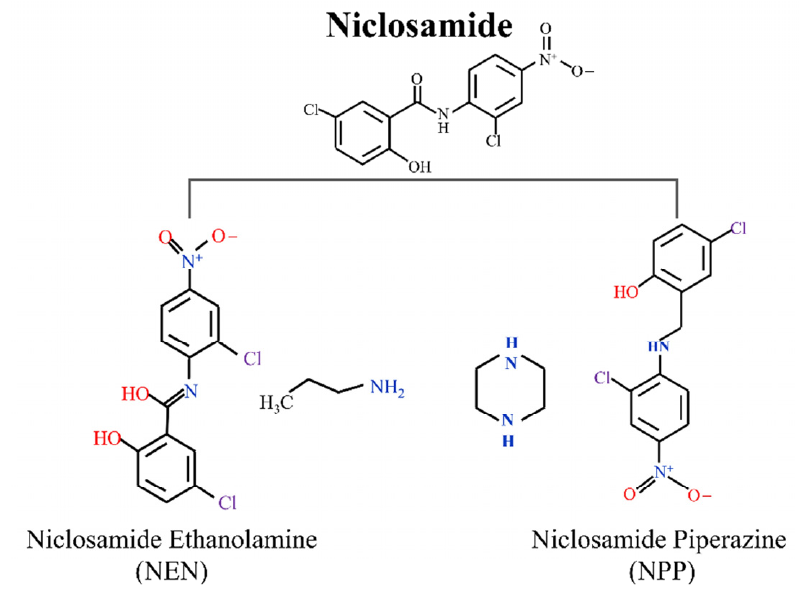
Figure 1. The structure of the two main salt forms of NIC: NEN and NPP.